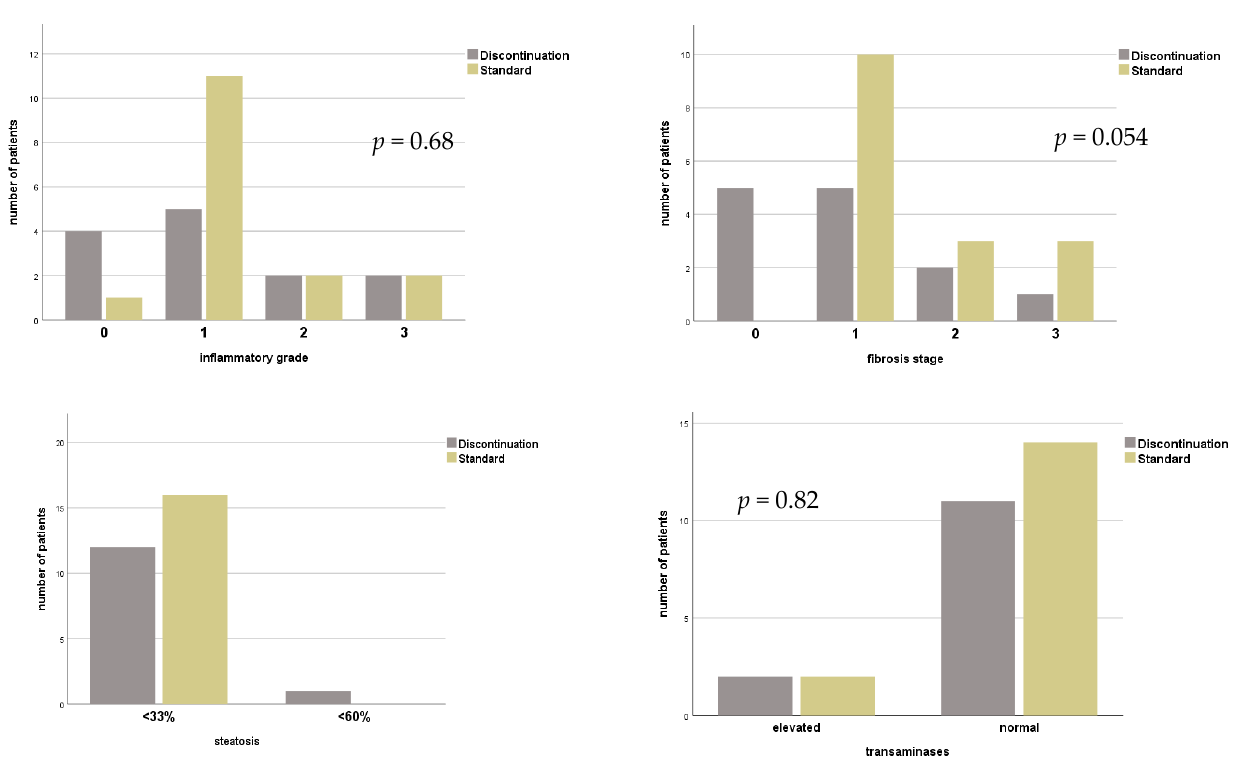
Figure 2. Histopathological findings and level of transaminases of patients with or without continuous HBIG prophylaxis for combined HBV/HDV infection before liver transplantation. Group standard—life-long combination of HBIG with NA; group discontinuation—discontinuation of HBIG.